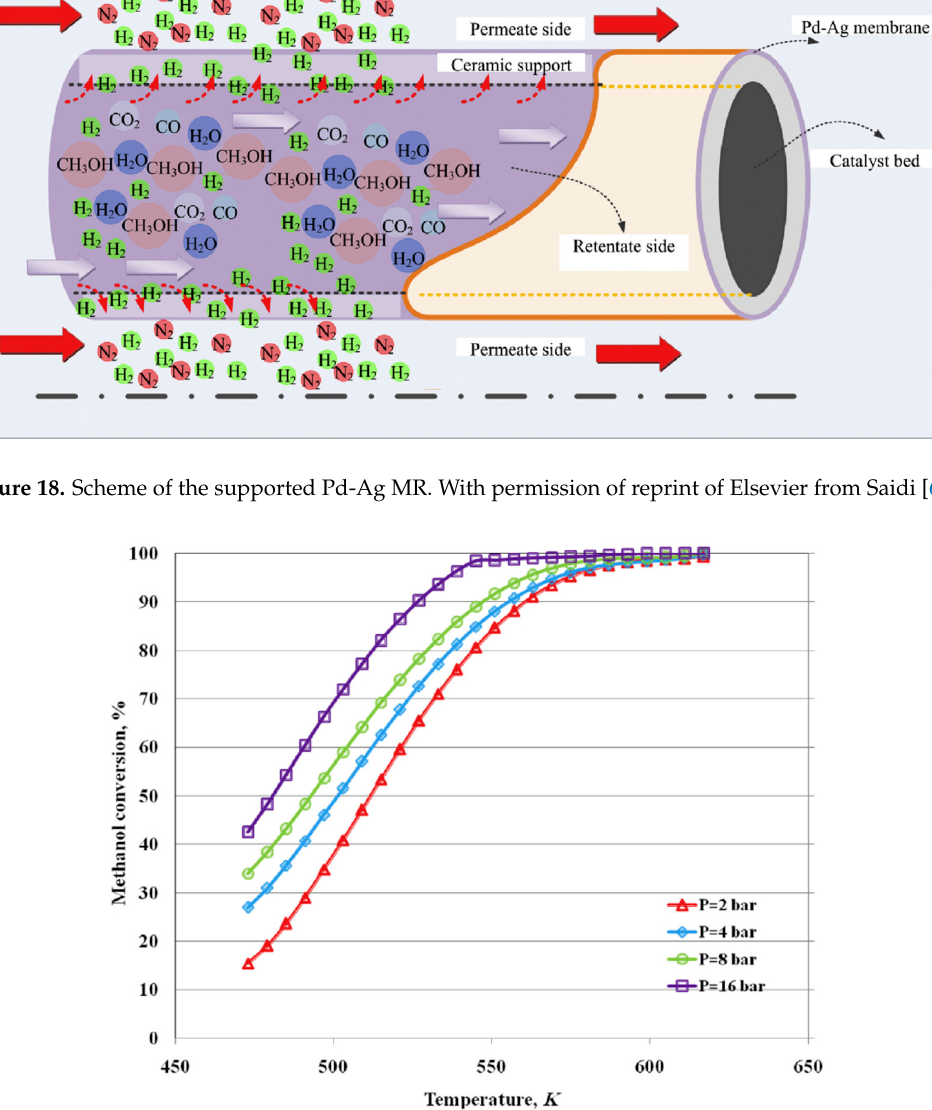
Figure 19. Simulation of MSR reaction in a supported Pd-Ag MR: methanol conversion vs temperature. With permission of reprint of Elsevier from Saidi [64].